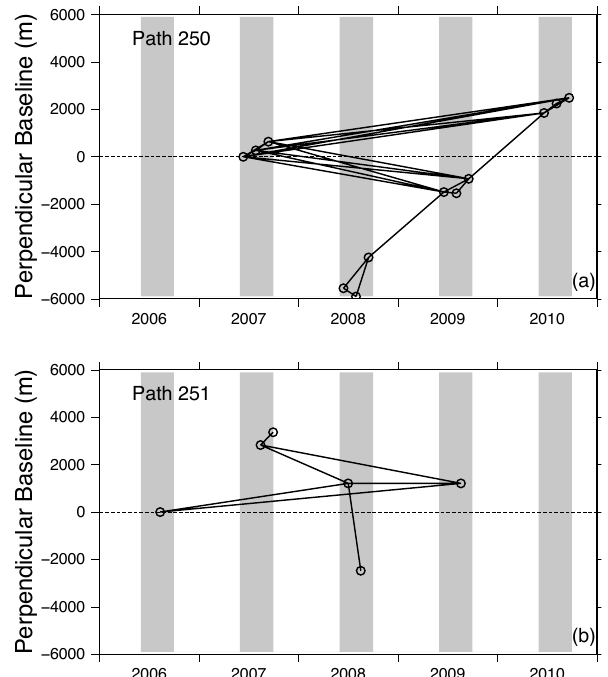
Fig. 2. Interferogram networks produced in this study using ALOS PALSAR data from two paths. Circles represent PALSAR acquisi- tions. Lines represent interferograms with sufficiently high coher- ence over SAC basin and vertical gray bars represent the thaw sea- son (June to September). Perpendicular baseline values are refer- enced to 13 June 2007 and 12 August 2006 for Paths 250 and 251,